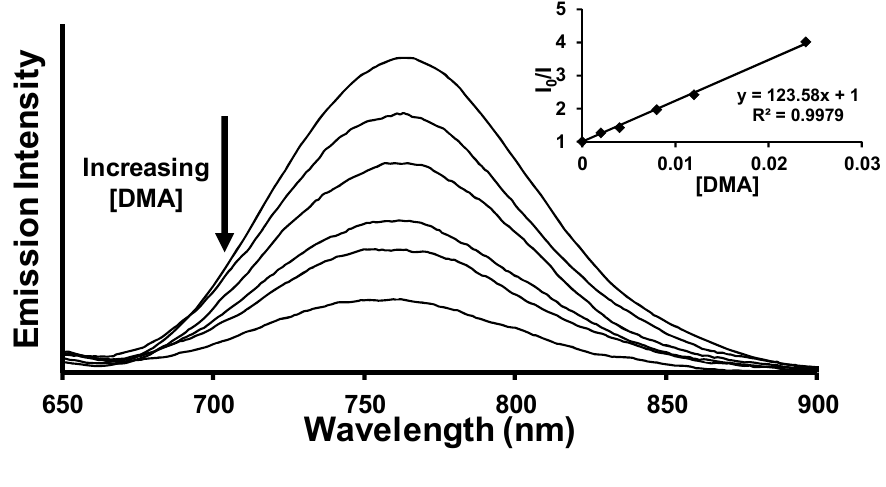
Figure 6. Emission quenching of [{(phen) DMA sacrificial electron donor. Inset: Stern-Volmer plot depicting linear relationship of emission quenching and DMA